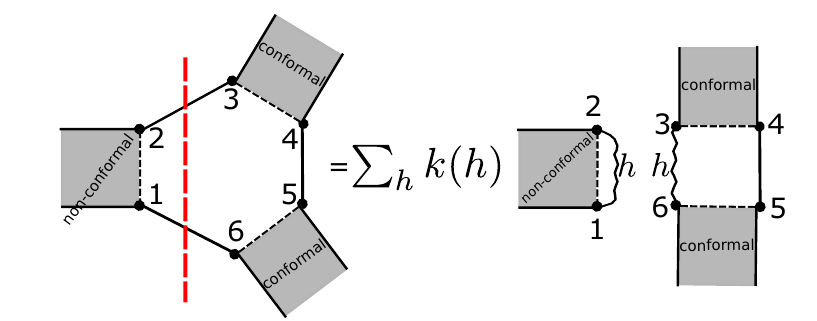
Figure 4: Di ff erent cuts of the 4-point vertex give the same result.